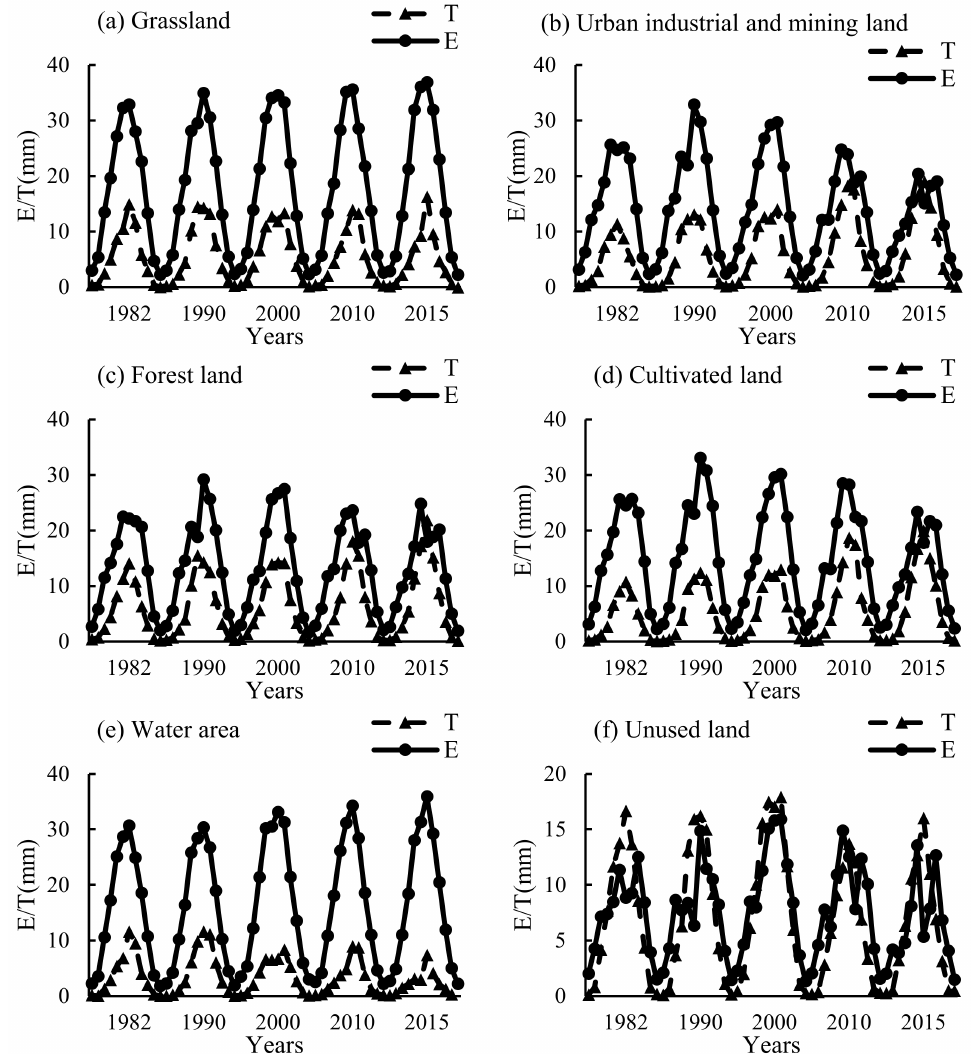
Figure 5. Comparison of monthly data of vegetation transpiration and soil evaporation in different land-use types from 1982 to 2015. ( a–f ) describe the variation trend of E/T in grassland, urban industrial and mining land, forest land, cultivated land, water area, and unused land, respectively. In different seasons, the T:E value changes in water area and grassland were gentle, with the maximum value in summer, close in autumn and spring, and the minimum in winter. The maximum T:E values appeared in the grassland and water area in 1990, which were 0.38 and 0.45, respectively, and the T values were much lower than the E values. In urban industrial and mining land, forest land, and cultivated land, the T:E values were in the following order, summer > spring > autumn > winter, and they showed a gradual increasing trend. The maximum values appeared in the 2015 summer, which were 0.91, 0.95, and 0.84, respectively. Each year, T:E values in unused land were larger than those in other land-use types. Except for 0.58 in 2010, the ratio was about 0.8 in other years, and T values were greater than E values in spring and summer (Table